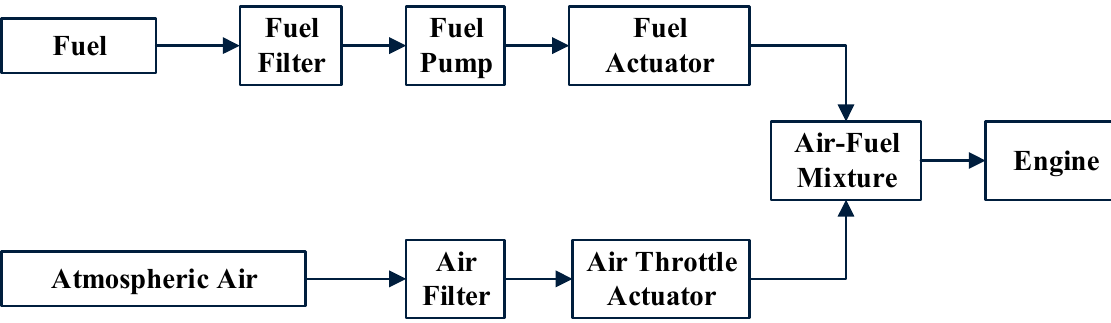
Figure 1. The architecture of the air–fuel system of an SI IC Engine [4].